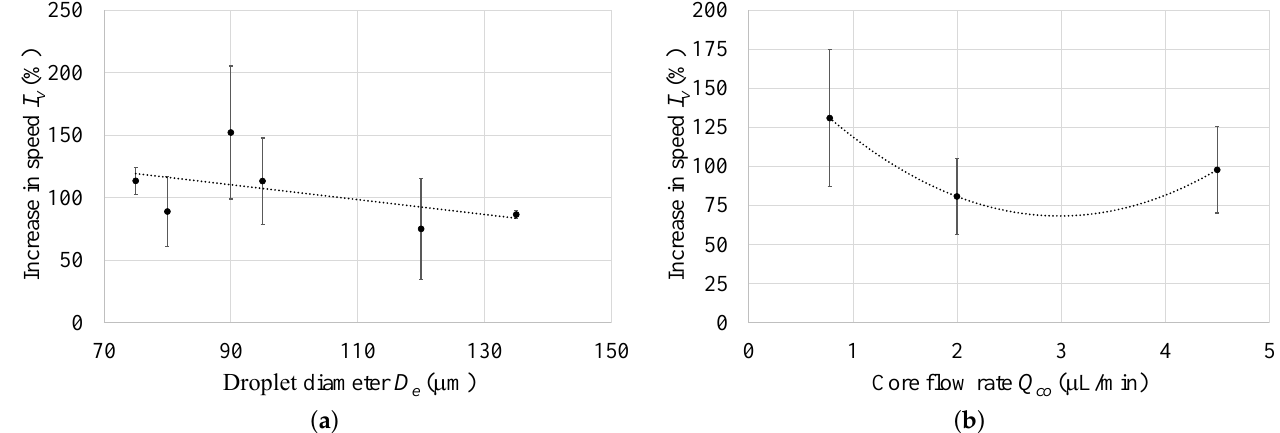
Figure 10. Increase in cell velocity ( I v ) due to the sheath flow at different values of: ( a ) droplet diameter D e , and ( b ) core flow rate Q co .